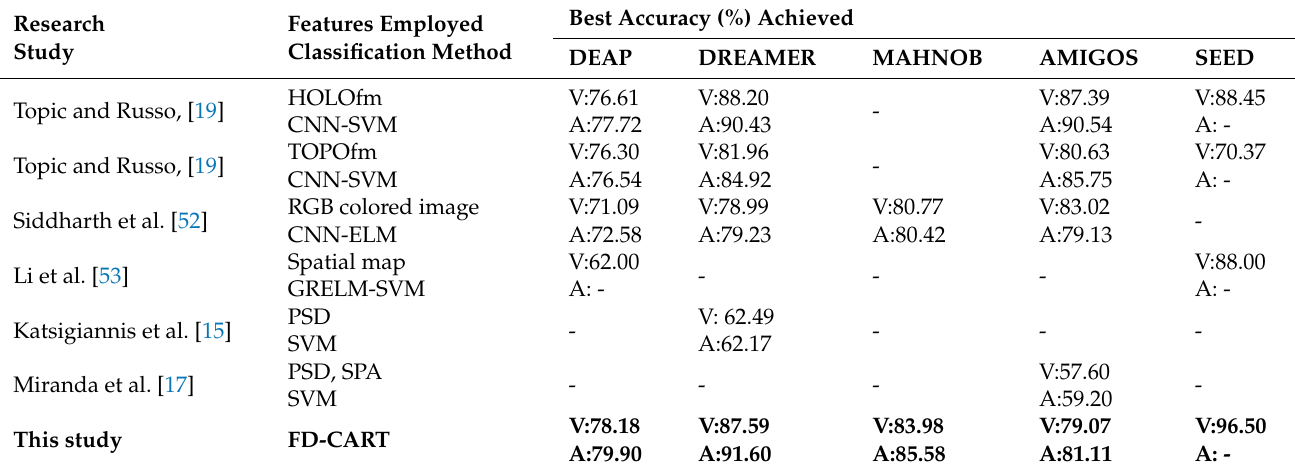
Table 6. Comparison with other studies in the